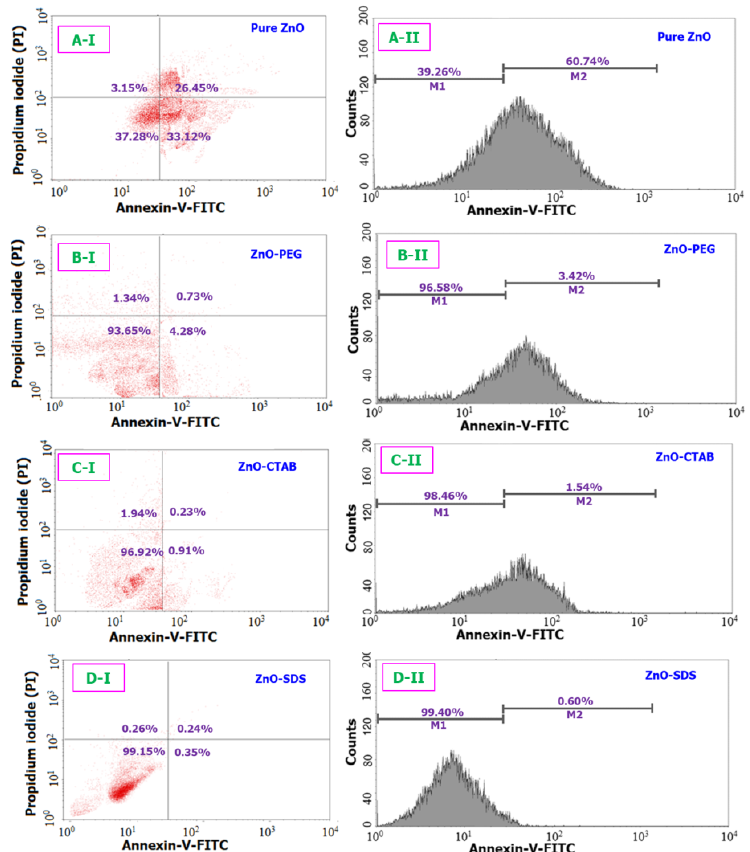
Figure 6. Comparison of the apoptosis assay results for all four different ZnO samples (IC 50 ) when tested over a 24 h period. ( A-I ) and ( A-II ) corresponds to the cellular differentiation and the fluorescence intensity (respectively) of pure ZnO sample. Likewise, ( B(I,II) – D(I,II) ) are related to ZnO-PEG, C-ZnO-CTAB, and D-ZnO-SDS samples respectively.